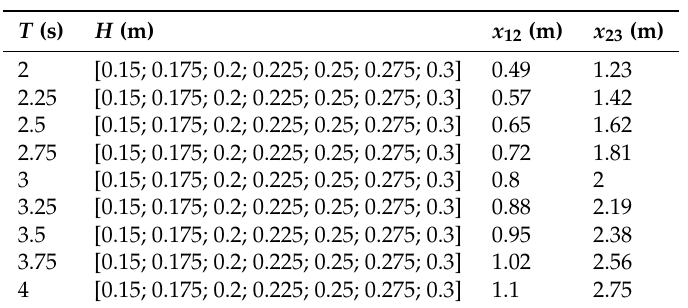
Table 1. Wave conditions used in the experimental